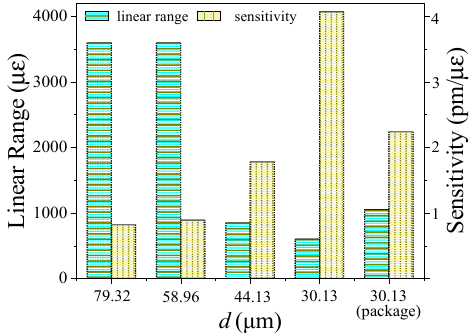
Figure 9. Comparisons in terms of strain sensitivity and linear range. Furthermore, the structure with d = 30.13 µm is selected for a temperature test, and the corresponding transmission spectrum is given in Figure 10a. The wavelengths of dips are red-shifted about 3.36 nm in the range of 25 − 85 °C. From Figure 10b, the sensitivities of dip1 and dip2 are 57.31 pm/°C and 56.78 pm/°C, respectively, with the linearity of >0.996. Such high sensitivity-consistency (~99.06%) provides the ability to eliminate the temperature crosstalk by the method of differential compensation [13,38–40]. In detail, the whole wavelength shift can be expressed as,